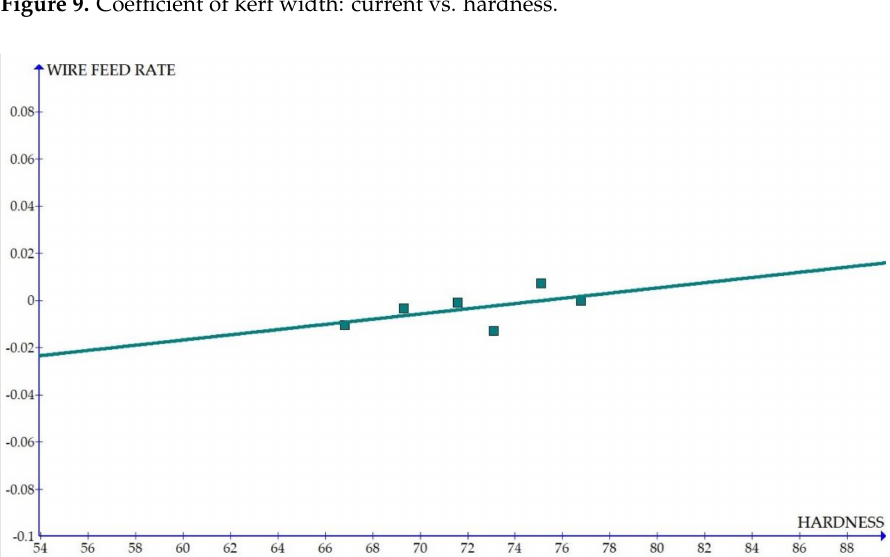
Figure 9. Coefficient of kerf width: current vs. hardness.